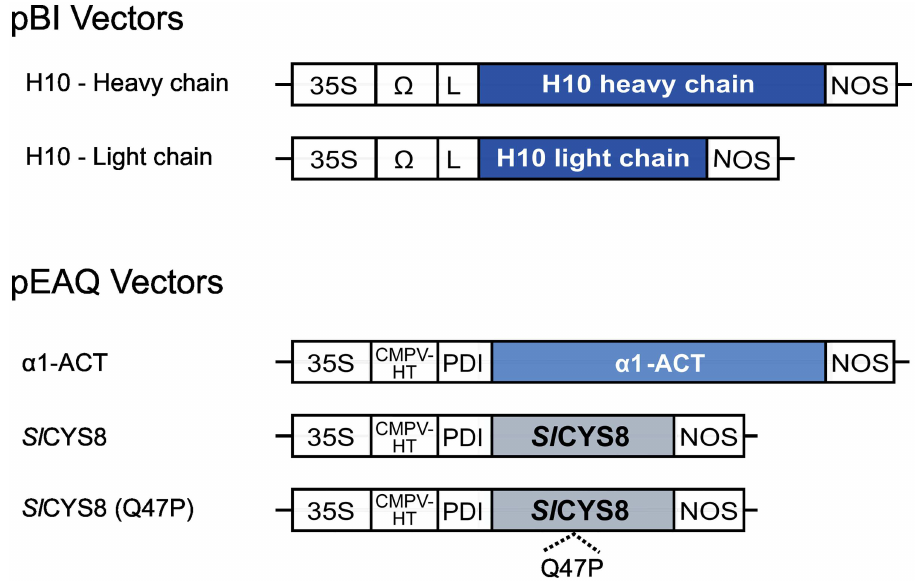
Fig 1. Gene constructs for antibody and protease inhibitor expressionin N . benthamiana leaves. The diagramidentifies codingsequencesof individual H10 antibodyheavy and light chains for insertion in a pBI expressionvector, and those of the accessory protease inhibitors α 1 -ACT, Sl CYS8 and Sl CYS8inactive mutant Q47P for insertionin a pEAQ vector. All codingsequenceswere placed under the control of a Cauliflower mosaic virus 35S promoter (35S) and an Ω or CPMV-HT translational enhancersequence.L, signalpeptidefor antibody chain cellularsecretion, from the heavy chain of an embryonic mouse immunoglobulin; PDI, signalpeptideof an alfalfa protein disulphide isomerase;NOS, nopalinesynthase terminator